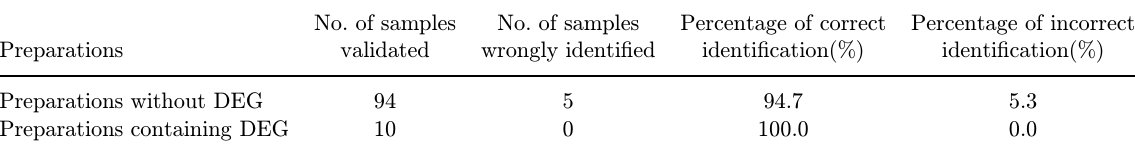
Table 2. Validation results of the identi¯cation method for the preparations containing DEG.